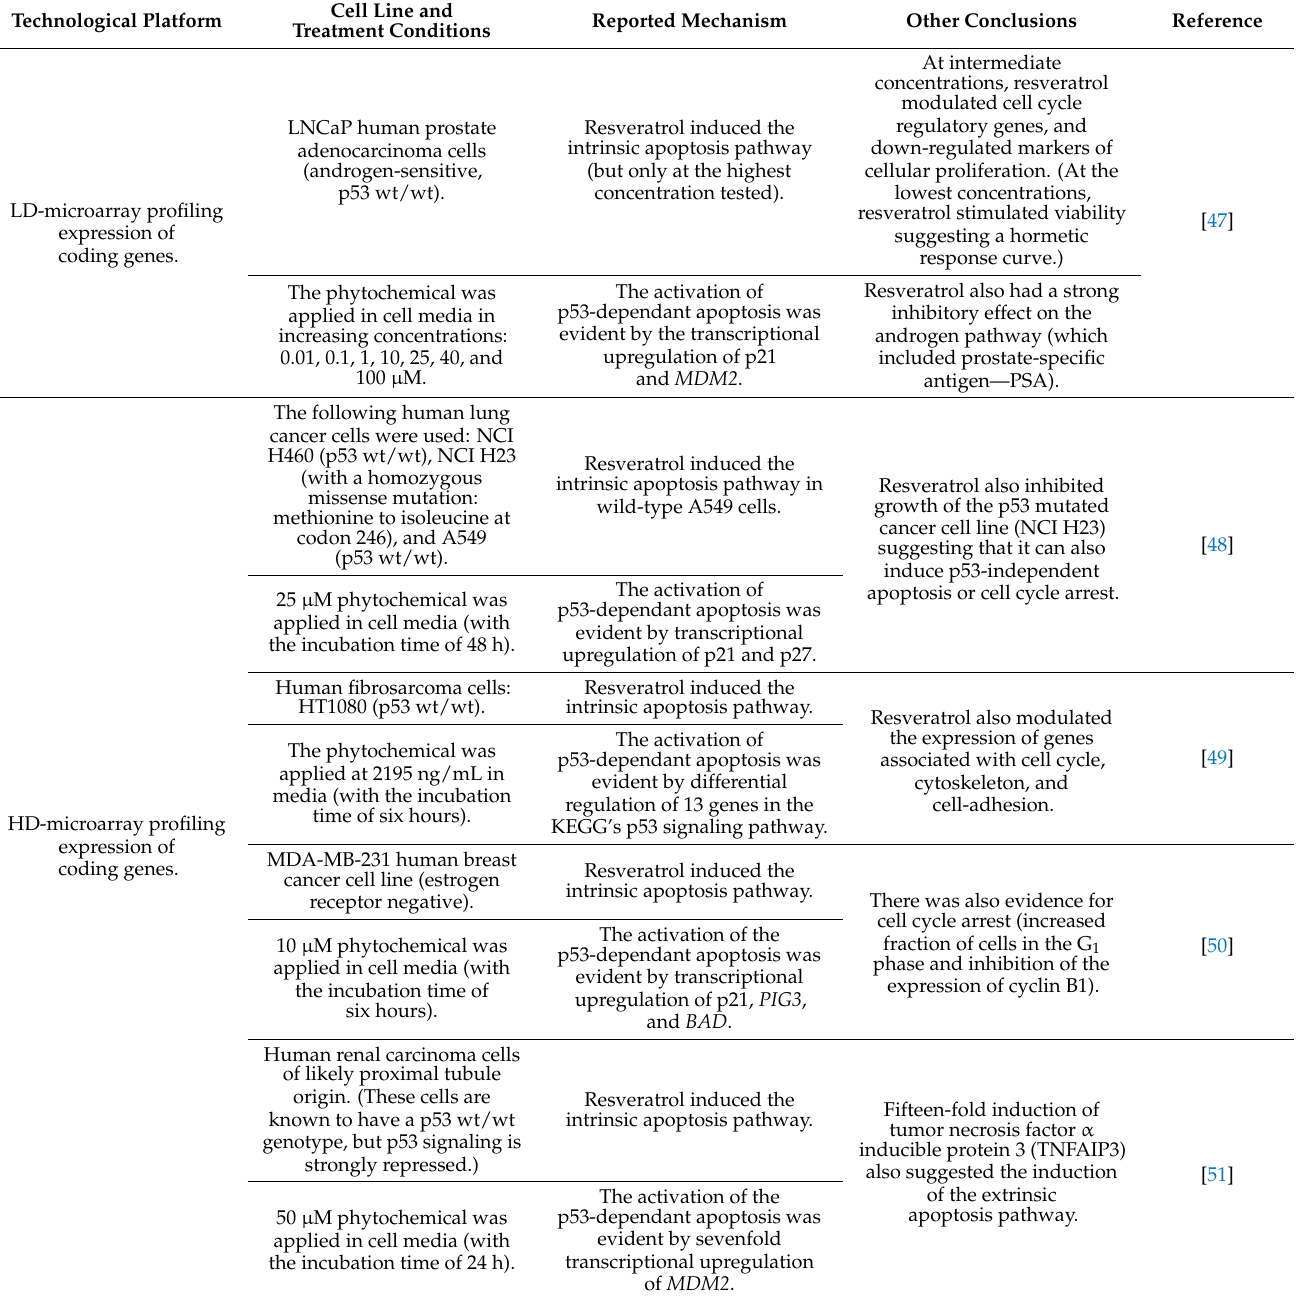
Table 3. There is strong evidence for the activation of the intrinsic apoptosis pathway by